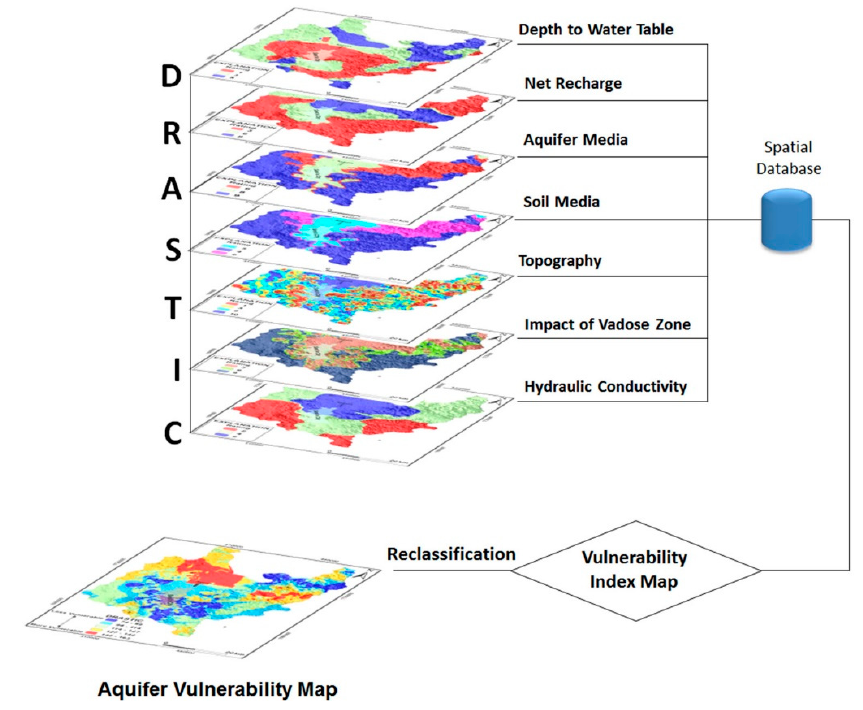
Figure 2. Methodology flowchart for the DRASTIC method [48].